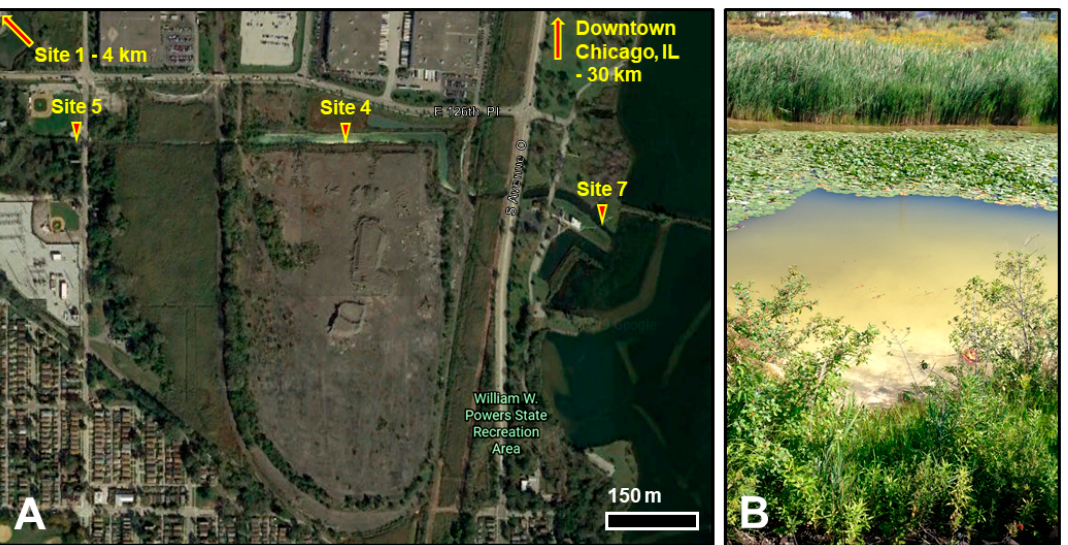
Figure 1. Indian Creek within the Calumet Wetlands in south Chicago, IL, USA. ( A ) Locations of sample sites around Indian Creek addressed in this work. Site 4 lies on the south bank of the canal, next to a 72-acre tract of exposed slag mounds. Hyperalkaline fluids seep out of the slag bank groundwater into the canal, raising pH above 9.5 year-round. Site 7 and Site 5 represent upstream and downstream control sites. Site 1, a hyperalkaline pond in Big Marsh Park, lies ca. 4 km to the northwest. Map data: Google. ( B ) View from the south bank at Site 4. Loose, yellow-white calcium carbonate flocculent fills the canal to a depth of >1 m near the spring seeps.